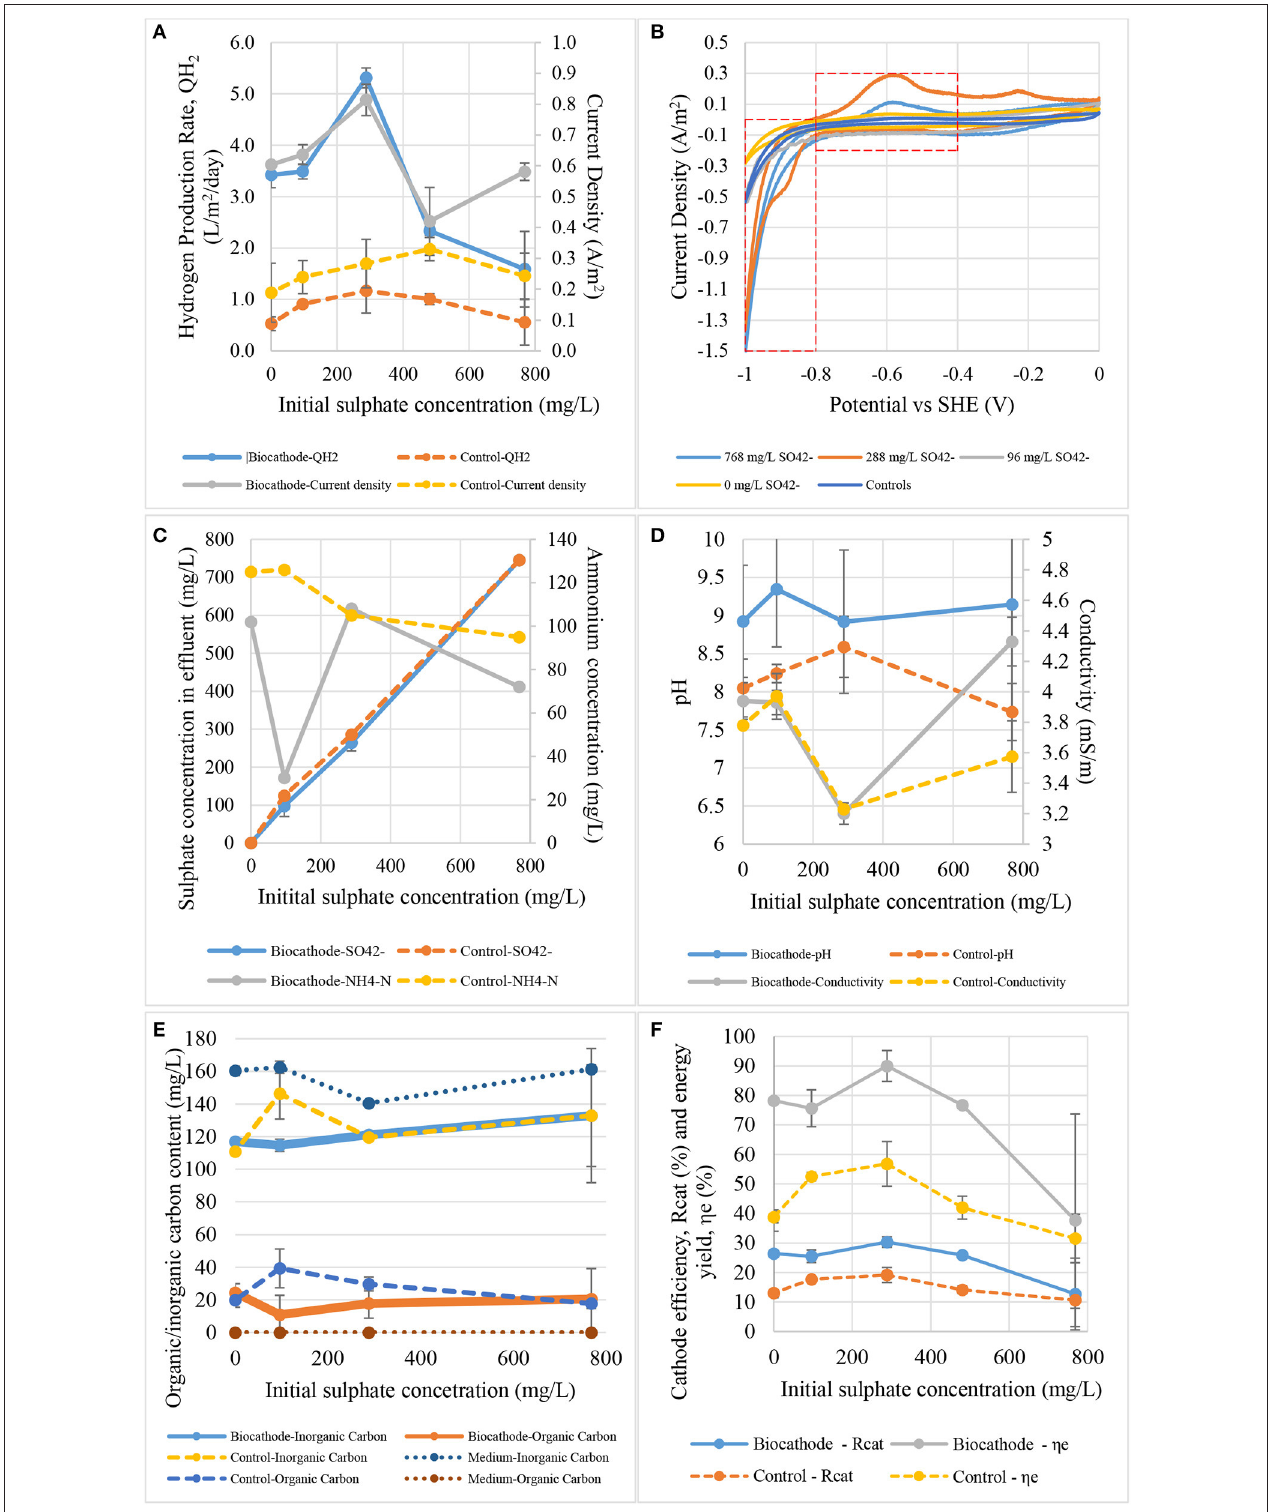
FIGURE 6 | The effect of initial sulfate concentration on: (A) hydrogen production rate and current density, (B) catalytic activity, (C) sulfate and ammonium contents, (D) pH and conductivity, (E) total carbon content, and (F) cathode efficiency and energy yield.